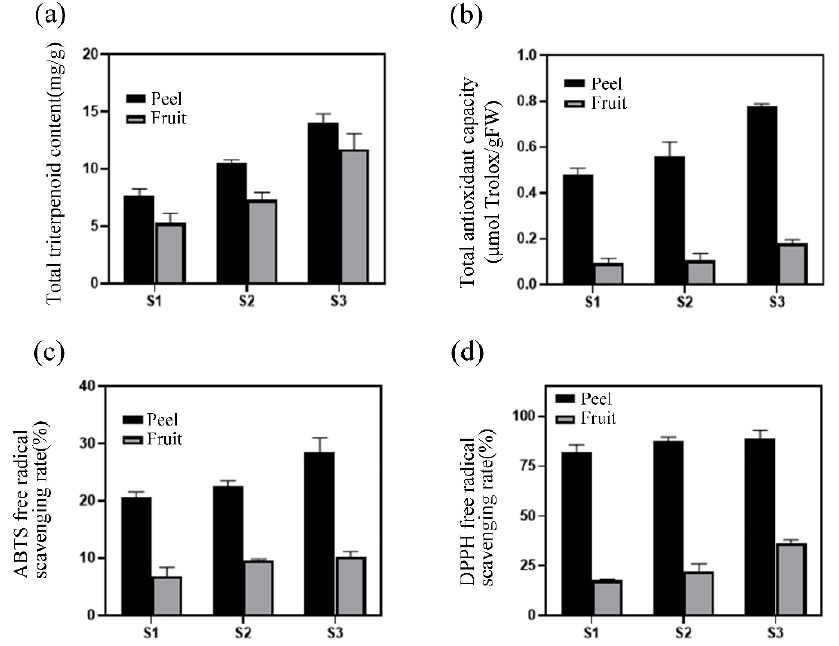
Figure 5. Analysis of antioxidant capacity: ( a ) total triterpenoid acid content; ( b ) total antioxidant capacity determination by FRAP method; ( c ) free radical scavenging rate determination by ABTS method; ( d ) determination of DPPH free radical scavenging rate.